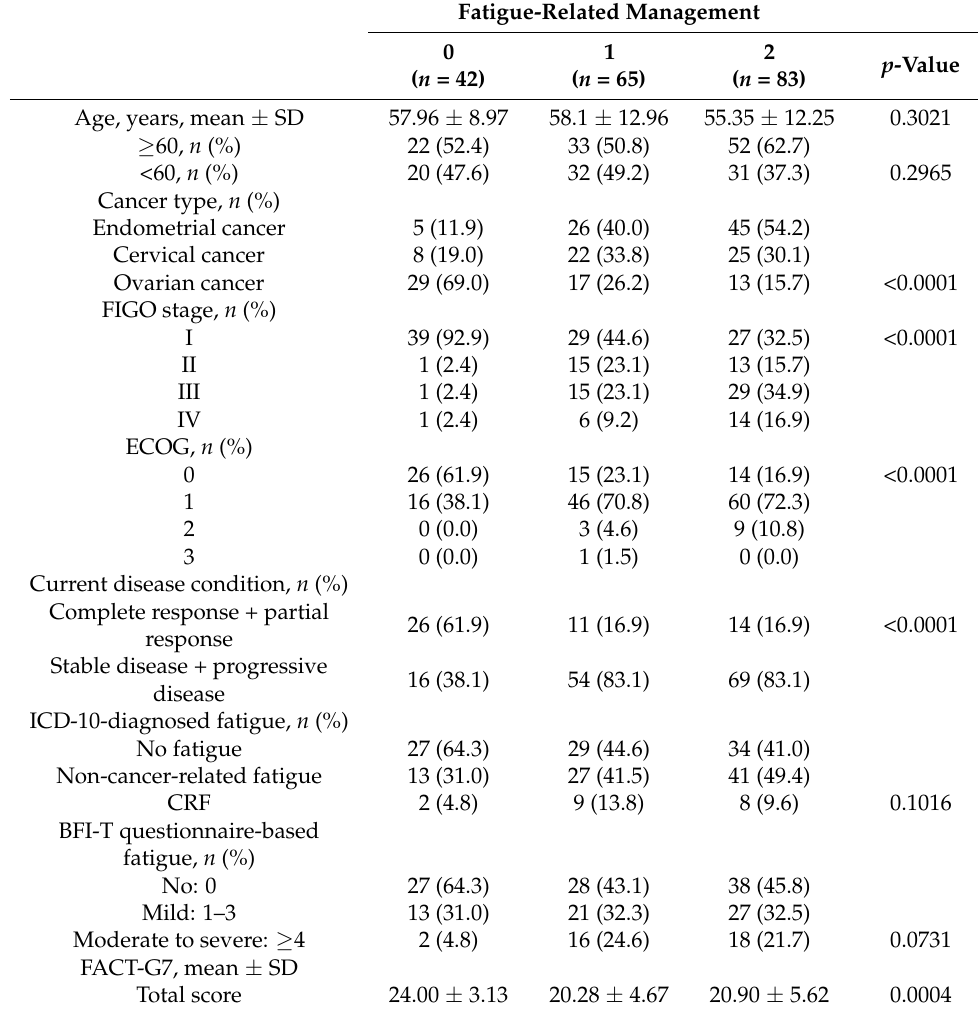
Table 2. Clinical characteristics for patients’ frequency of seeking fatigue-related